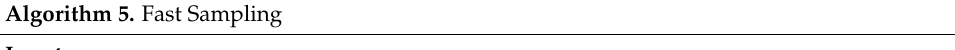
Figure 3. Schematic illustration of the Fast-Sampling sampling strategy. The red circle is the explored area. Since the first sampling point x rand 1 falls in the explored area, it is regarded as an invalid sampling. After re-sampling, the second sampling point x rand 2 is obtained. x rand 2 bootstrap tree expansion to obtain x new , thus avoiding invalid expansion. Algorithm 5. Fast